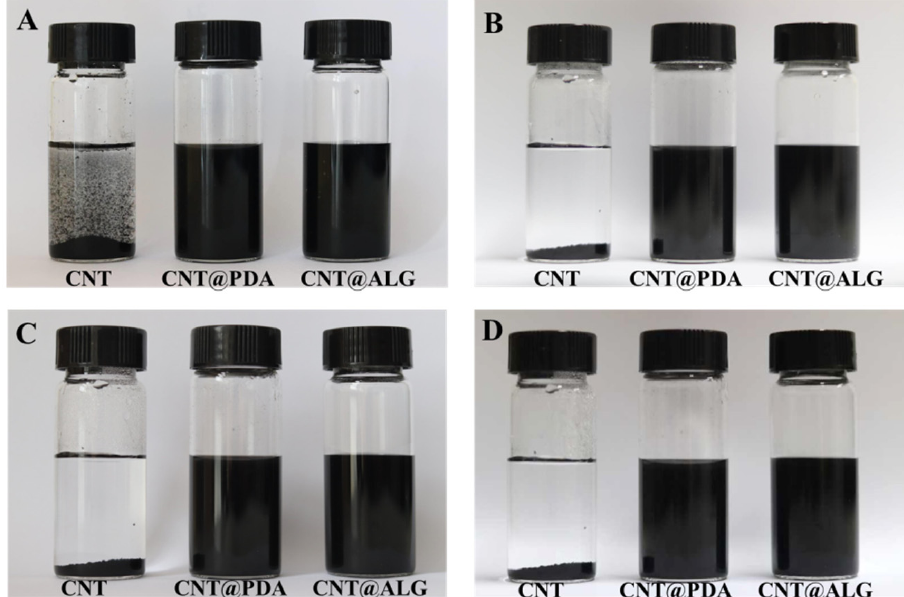
Figure 3. The photos of CNT, CNT@PDA, CNT@ALG after dispersed in water for 1 min ( A ), 4 h ( B ), 24 h ( C ) and 1 week ( D ).